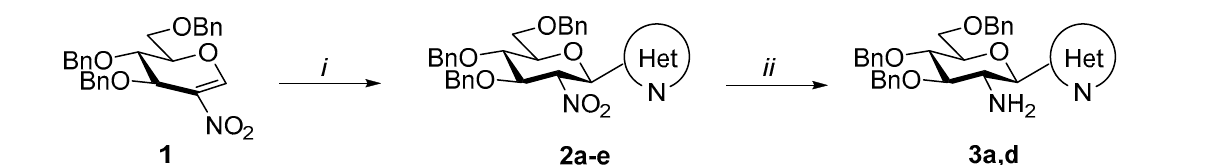
Table 1. Synthesis of C -(2 (cid:48) -deoxy-2 (cid:48) -nitro-3 (cid:48) ,4 (cid:48) ,6 (cid:48) -tri- O -benzyl- β - D -glucopyranosyl)azines and their